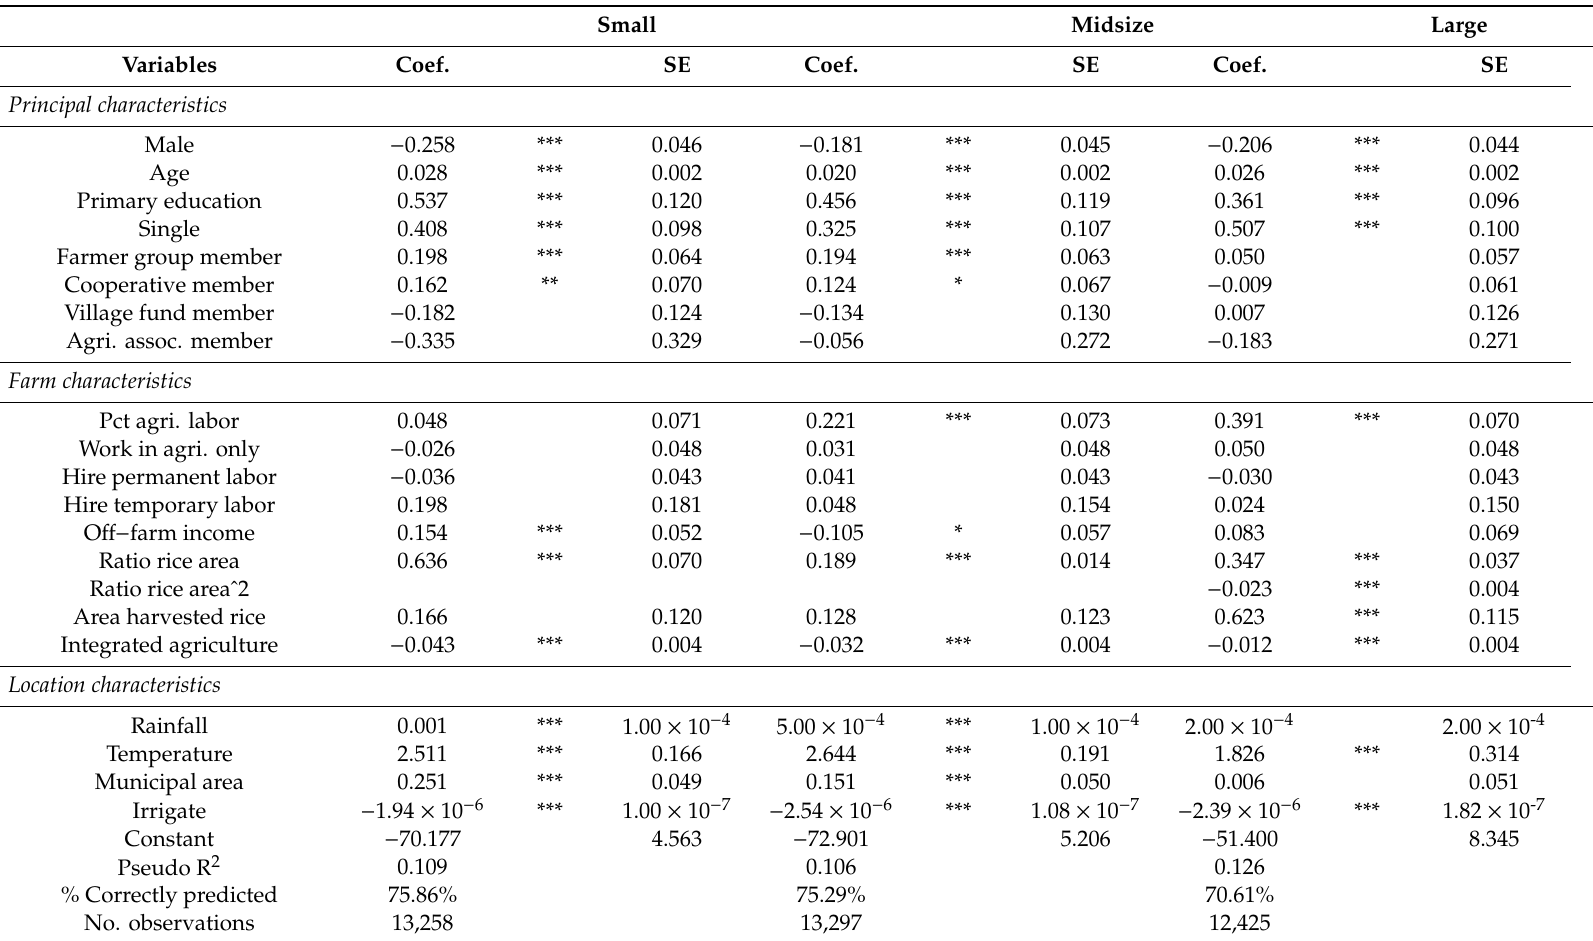
Table 5. Estimated coe ffi cients from logit models classified by farm type: weak land ownership. Small Midsize Large Variables Coef. SE Coef. SE Coef.